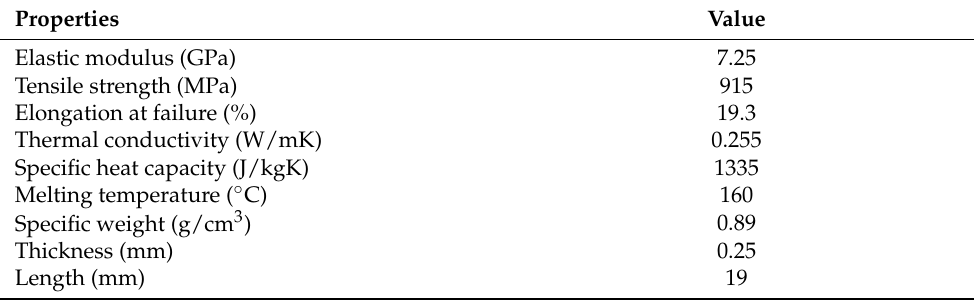
Table 1. Physical and mechanical attributes of PFF.